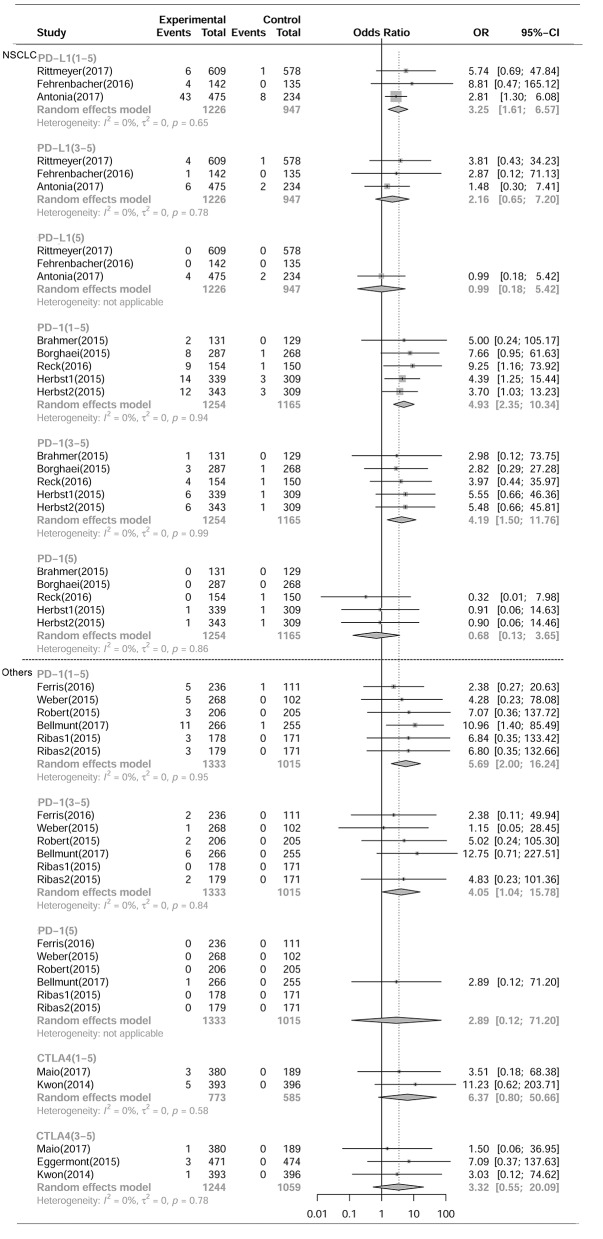
Forest plot analysis of pneumonitis of different ICIs in different tumoral types. NSCLC, non-small cell lung cancer; Others, including MM, HNSCC, Prostate cancer, Mesothelioma. PD-L1, PD-L1 inhibitor V.S. chemotherapy/placebo; PD-1, PD-1 inhibitor V.S. chemotherapy; CTLA4, CTLA4 inhibitor V.S. chemotherapy/placebo; G1-5, grade 1-5; G3-5, grade 3-5, G5, death.